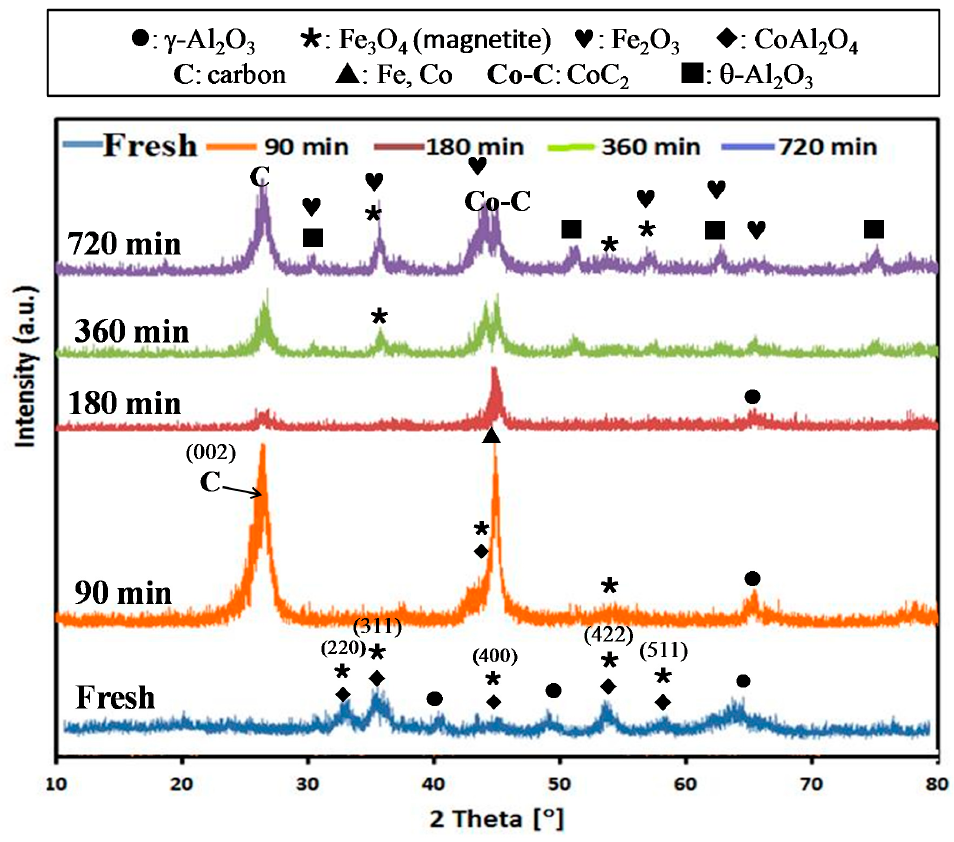
Figure 1. X-ray diffraction (XRD) patterns of fresh, spent, and spent/regenerated catalysts.